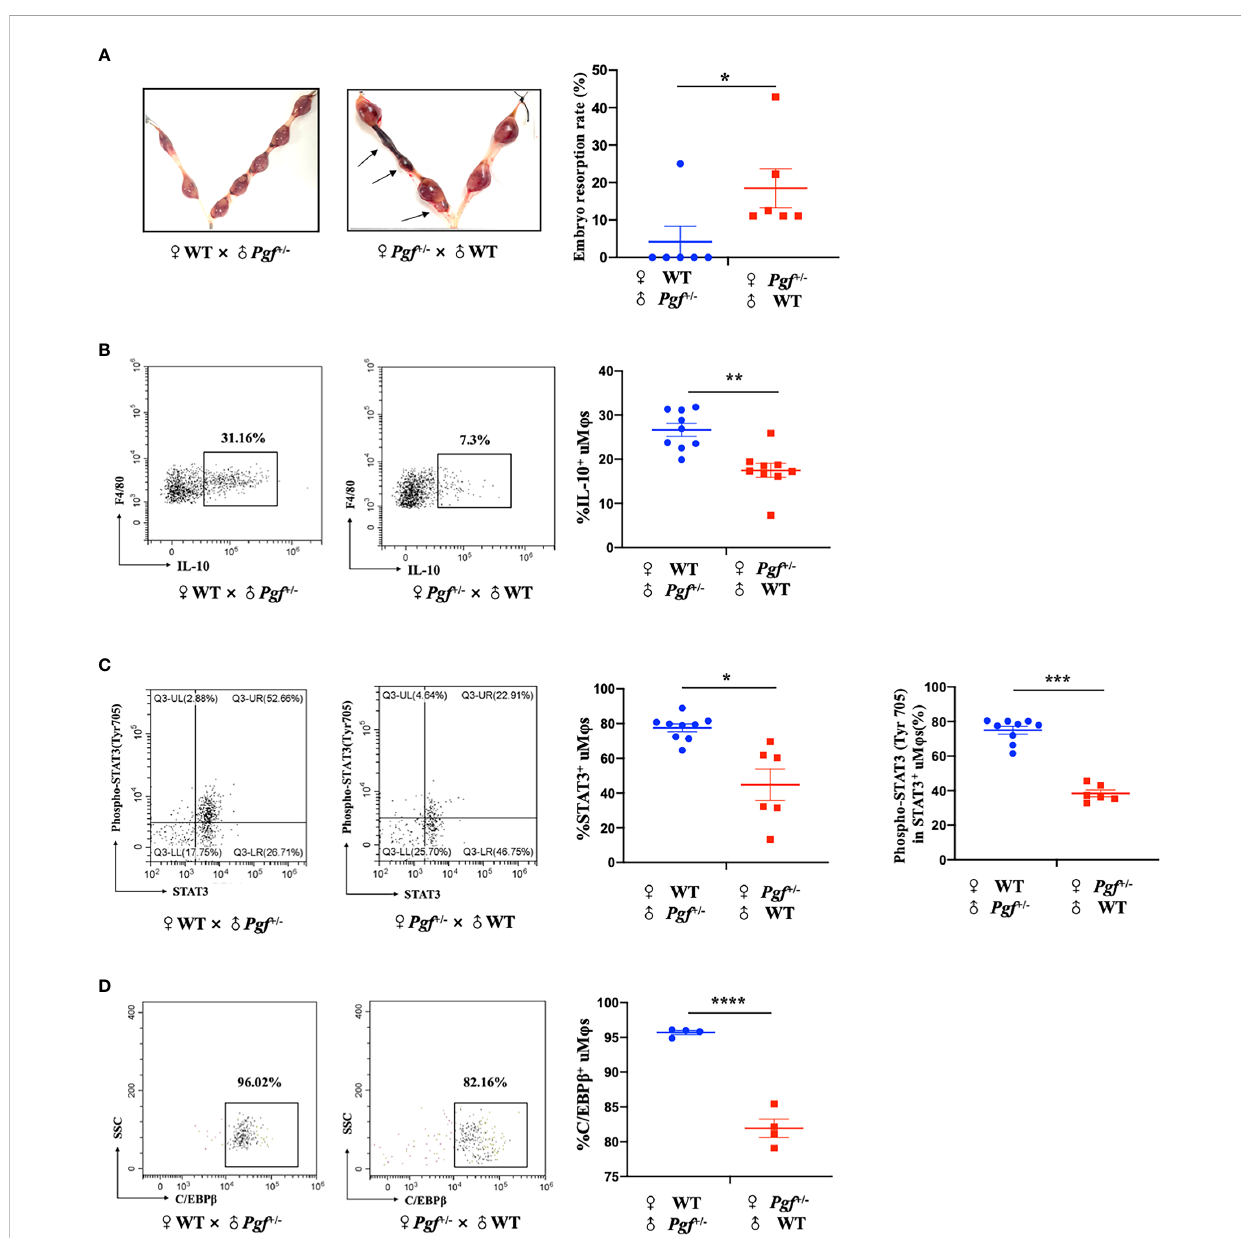
FIGURE 5 The maternal PlGF de fi ciency leads to uterine macrophage dysfunction and fetal loss in Pgf knockout mice. (A) The embryo resorption rate in the control group (wild-type females × Pgf - /+ males, n=6) and experimental group ( Pgf - /+ females × wild-type males, n=6) at embryonic day 13.5. (B) Flow cytometry (FCM) analysis of IL-10 expression on uterine macrophagesa in the control group (n=9) and experimental group (n=9) at embryonic day 8.5. (C) The expression level of STAT3 and the phosphorylation level of STAT3 at tyrosine 705 (Tyr 705) in uterine macrophages in the control group (n=9) and experimental group (n=6) by FCM analysis at embryonic day 8.5. (D) FCM analysis of C/EBP b expression on uterine macrophages in the control group (n=4) and experimental group (n=4) at embryonic day 8.5. Data were analyzed by Student ’ s t-test or Wilcoxon rank-sum test, and shown as mean ± SEM. * P < 0.05, ** P < 0.01, *** P < 0.001, and **** P < 0.0001. WT,